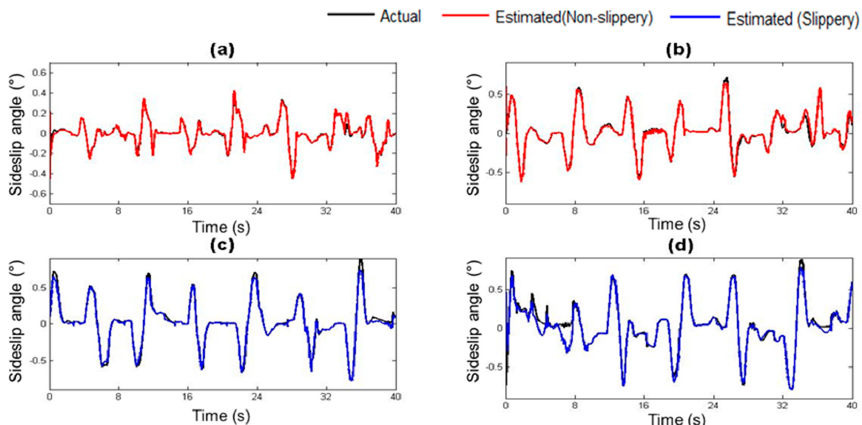
Figure 11. Estimated Side slip angle depending on road surface condition: ( a ) Dry asphalt; ( b ) Gravel; ( c ) Wet; and ( d ) Snowy.